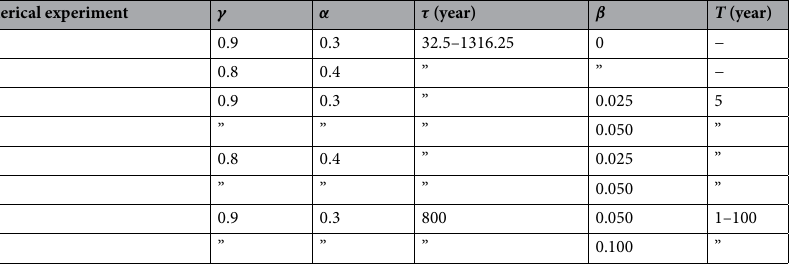
Table 1. List of the numerical experiments; see Eq. (2) for the definition of the parameters. In experiments Exp1–Exp6, the duration τ = t 2 − t 1 of the ramp takes on 80 different values that range from 32.5 to 1316.25 year. In experiments Exp7 and Exp8, the period T ranges from 1 to 100 year. For each value of τ or T , an ES with 168 initial states is carried out. Quotation marks in the table indicate identical